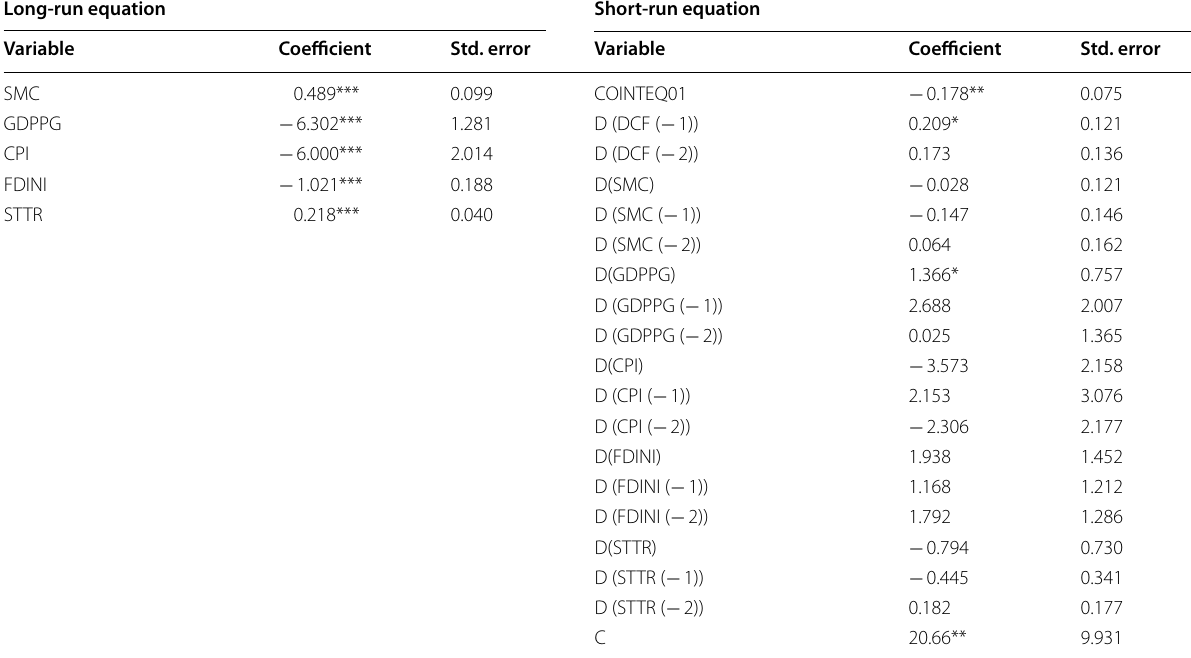
The dependent variable is D(DCF), at lags 3(Fixed). SMC, GDPPG, CPI FDINI, and STTR. Standard errors in parentheses *** p < 0.01, ** p < 0.05, * p < 0.1, in all the models of the current study